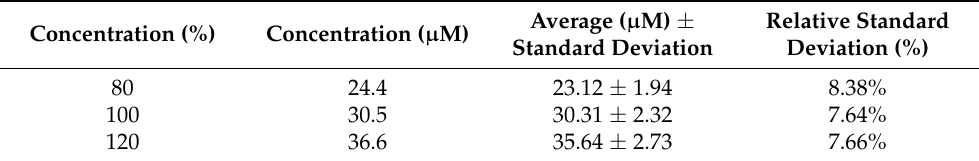
Table 2. Precision and accuracy of the CP-50ME biosensor in 100 mM sodium acetate buffer pH 5.0 after 2 min and 30 s of enzymatic reaction in the determination of catechin. The average provided corresponds to three determinations.